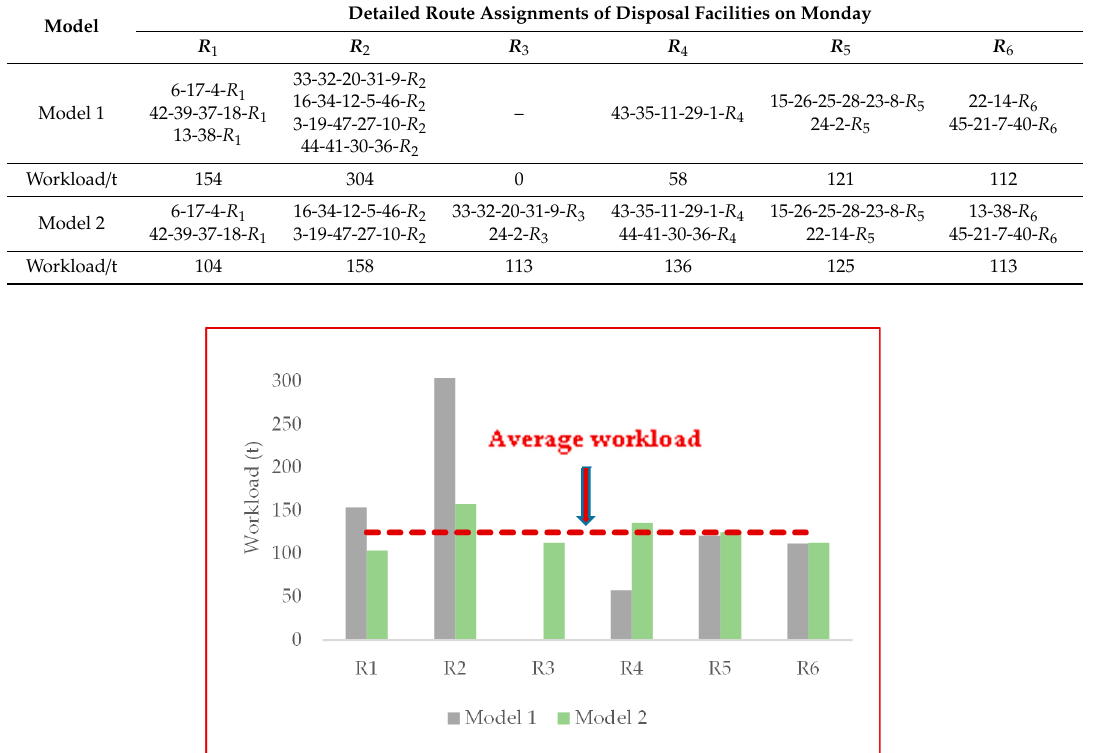
Figure 9. Workload of six disposal facilities in two models and the average workload on Monday (Average workload = 125 t).